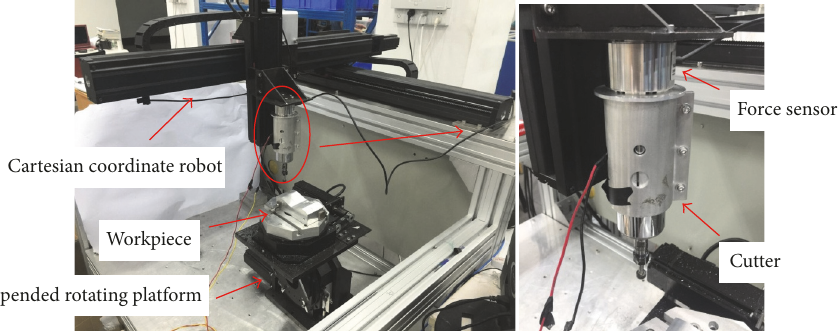
Figure 8: Architecture of robotic cutting system ((1) 𝑋𝑌𝑍 Cartesian coordinate robot; (2) rotating platform; (3) six-axis force sensor; (4) cutting tool; (5) workpiece).